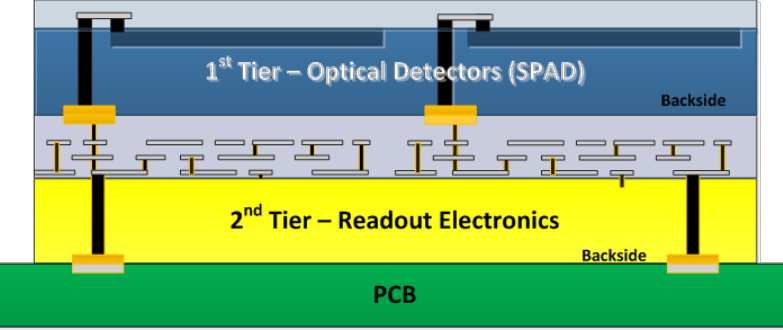
Figure 1. Cross-section of the 3D digital SiPM. The first tier contains SPAD arrays with through silicon vias (TSV) and the second tier contains quenching circuit and time-to-digital converter